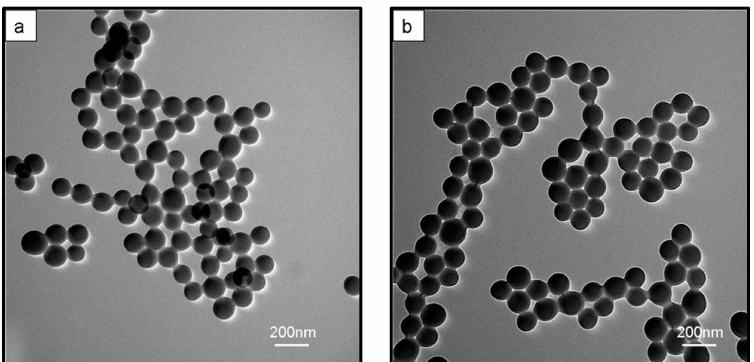
Figure 4. TEM micrographs of the final particles prepared by emulsion polymerization of styrene using methanol solution (20/80 w / w ) as the polymerization medium and various reaction temperatures: ( a ) 55 ˝ C and ( b ) 75 ˝ C. The TEM micrograph of the final particles prepared by emulsion polymerization of styrene at 65 ˝ C is shown in Figure